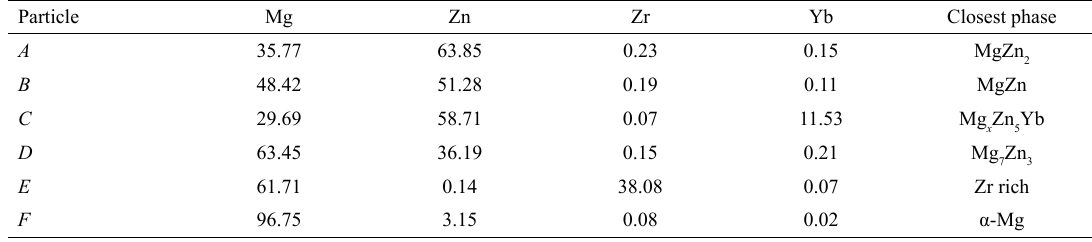
Table 1. Compositions of particles within the as-cast samples (see Figure 2c) measured by EDS (at.%).